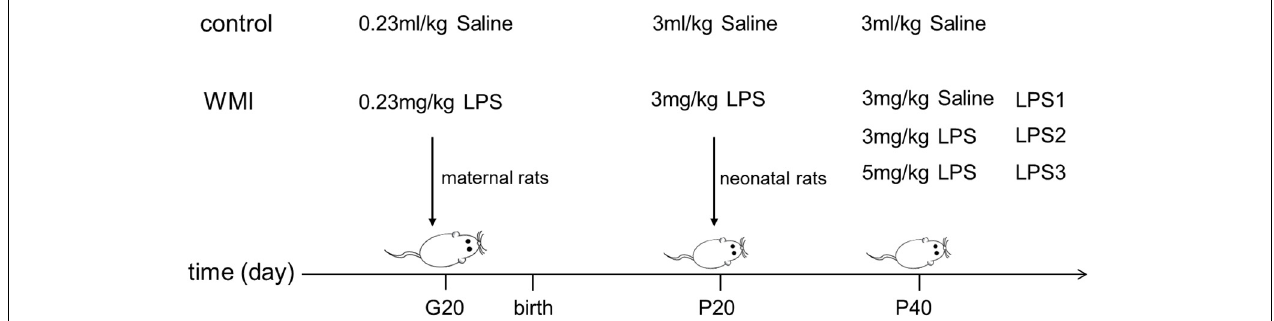
FIGURE 1 | Administration methods for animal models. The image shows the time and dose of intraperitoneal injection of drugs in each group. Pregnant rats were given the first injection at 20 days of gestation (G20), and the second injection of LPS was conducted on neonatal rats at postnatal day 20 (P20) to construct the WMI animal model. We divided experimental mice into three groups and again intraperitoneally injected LPS consisting of low to high concentration gradients at postnatal 40 (P40), to mimic the adverse effects of multiple infections early in